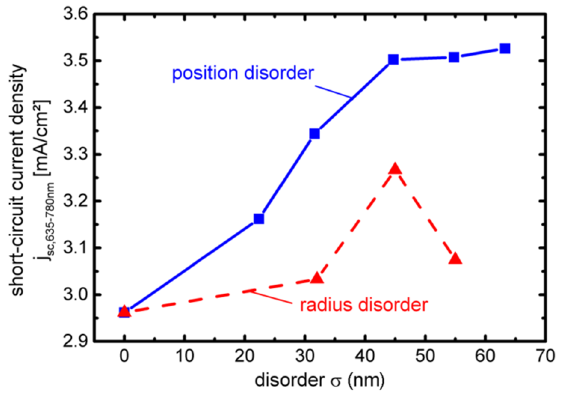
Figure 6. Impact of different types of disorder on the short-circuit current density of the a-Si:H solar cell in the wavelength range from 635 nm to 780 nm.